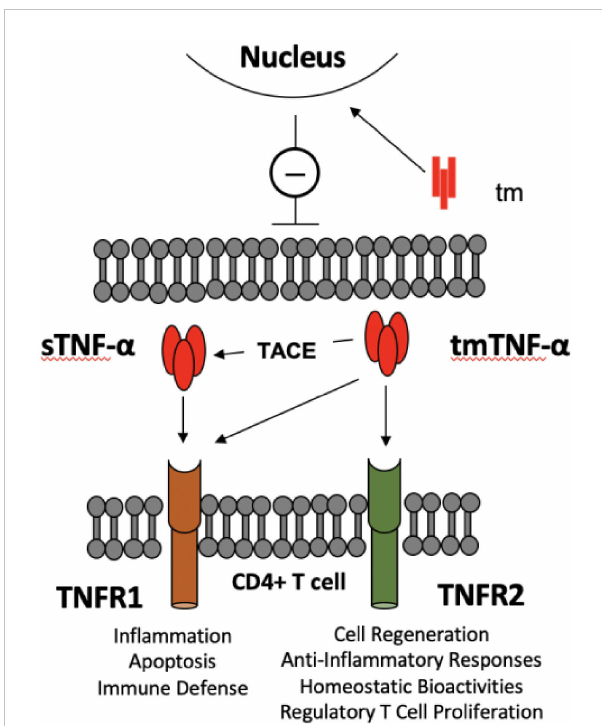
FIGURE 1 TNF- a -TNF- a receptors crosstalk between TLR-Bregs and effector CD4 + T cells. There are two molecular entities of TNF- a : a membrane- bound trimer of a single polypeptide chain (tmTNF- a ), which is the precursor of a soluble trimer TNF- a (sTNF- a ) obtained from cleavage by the tumor necrosis factor converting enzyme (TACE). The main